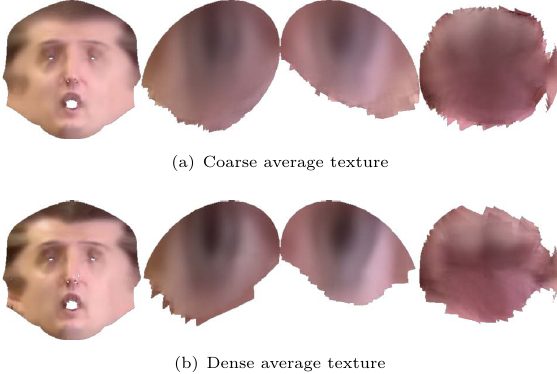
Fig. 4 Refined texture after robust dense